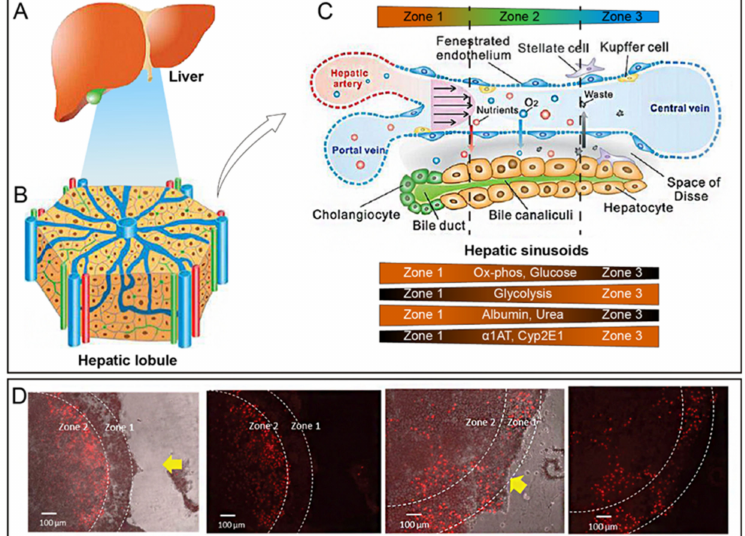
Figure 1. Cellular composition and anatomical microstructure of the liver. ( A ) Shape of the liver. It is a red-brown V-shaped organ divided into right and left parts by the hepatic artery, portal vein, hepatic vein, and bile ducts. ( B ) The liver lobule has a hexagonal shape with a diameter of about 1 mm and thickness of about 2 mm. ( C ) Zonation in the lobule. Reproduced with permission from [33]. ( D ) Zonal heterogeneity of acetaminophen-induced hepatotoxicity. The yellow arrow indicates the flow direction. Reproduced with permission from [34].